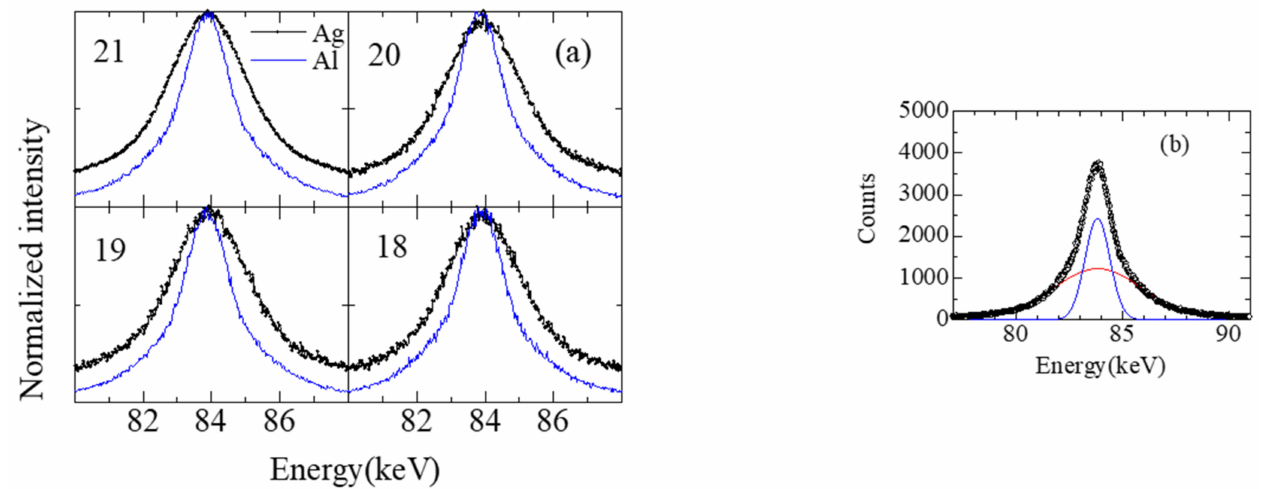
Figure 3. ( a ) Compton scattered spectra for Al and Ag. ( b ) An example of two Gaussian fitting of a Compton scattered X-ray spectrum for A1, 21st harmonic order of undulator. Circle: experimental, Red: Width_1 (Broad). Blue: Width_2 (Narrow). Bold: Fitting result (Width_1 + Width_2).